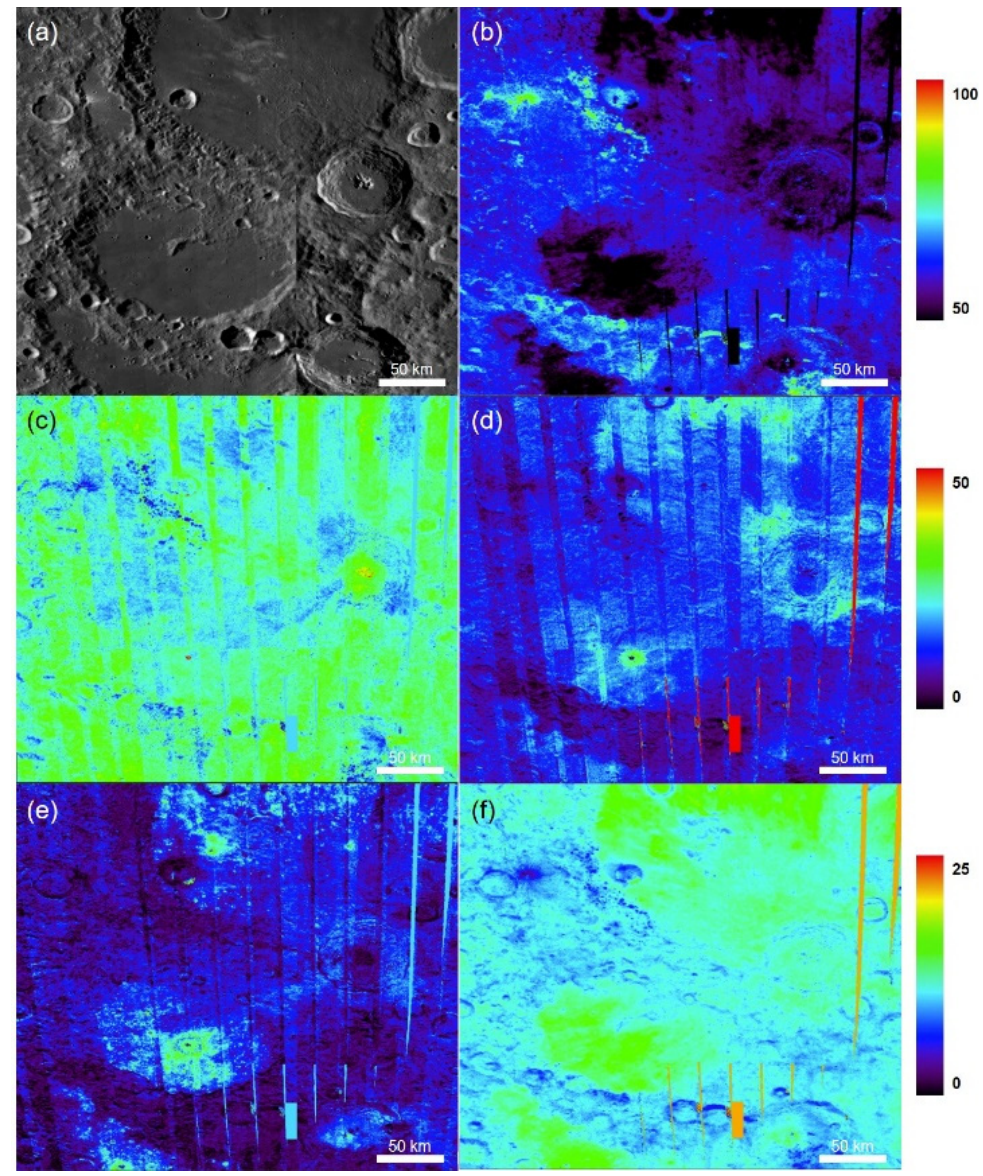
Figure 10. Distribution of mineral abundance of the area around the Von Kármán crater (https://quickmap.lroc.asu.edu/)(accessed on 27 December 2021). ( a ) WAC Mosaic and NACs of LROC. Mineral abundance (wt%) detected using Kaguya multi-band imagery data: ( b ) plagioclase, ( c ) orthopyroxene, ( d ) clinopyroxene, ( e ) olivine, and ( f ) FeO. ( c ) orthopyroxene, ( d ) clinopyroxene, ( e ) olivine, and ( f )